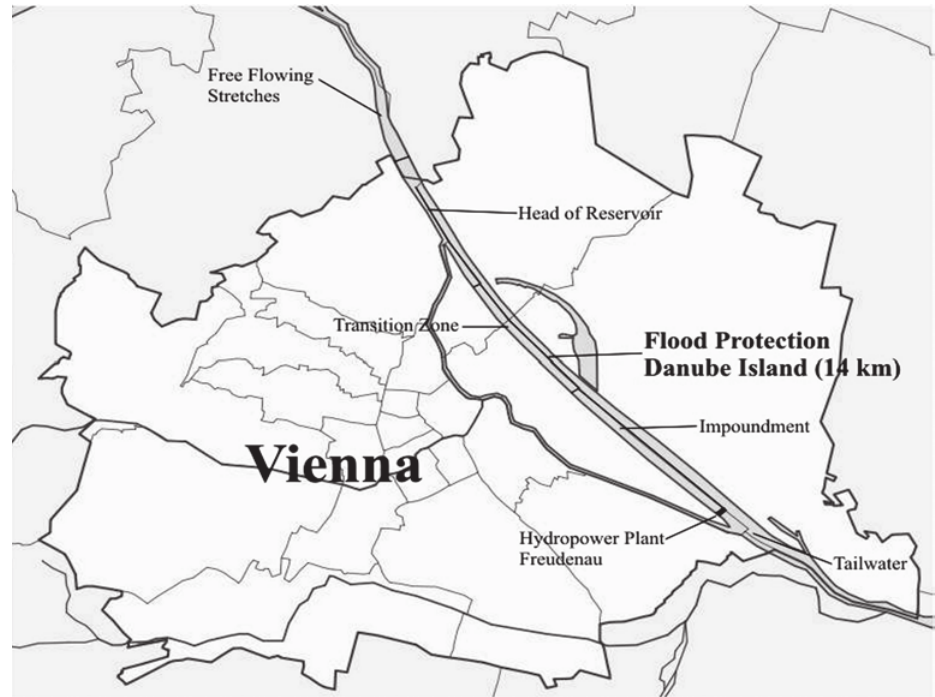
Figure 1. Map of the investigation area including the five sections Tailwater, Impoundment, Transition Zone, Head of Reservoir and Free Flowing